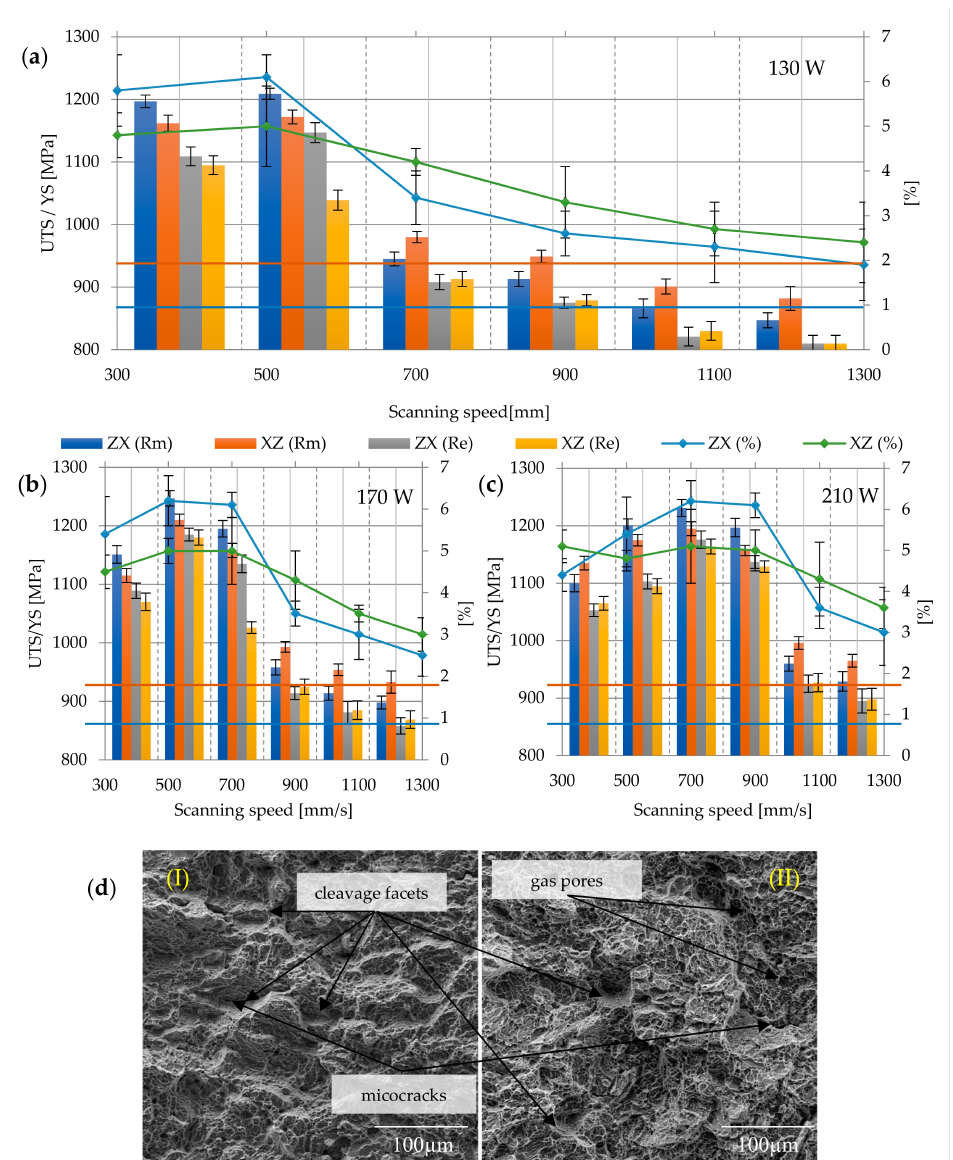
Figure 7. Strength parameters of samples heat treated at 650 ◦ C with di ff erent laser speeds and powers: ( a ) 130 W, ( b ) 170 W, ( c ) 210 W, and ( d ) fracture surface: (I) 130 W, 300 mm / s, ZX; (II) 130 W, 300 mm /